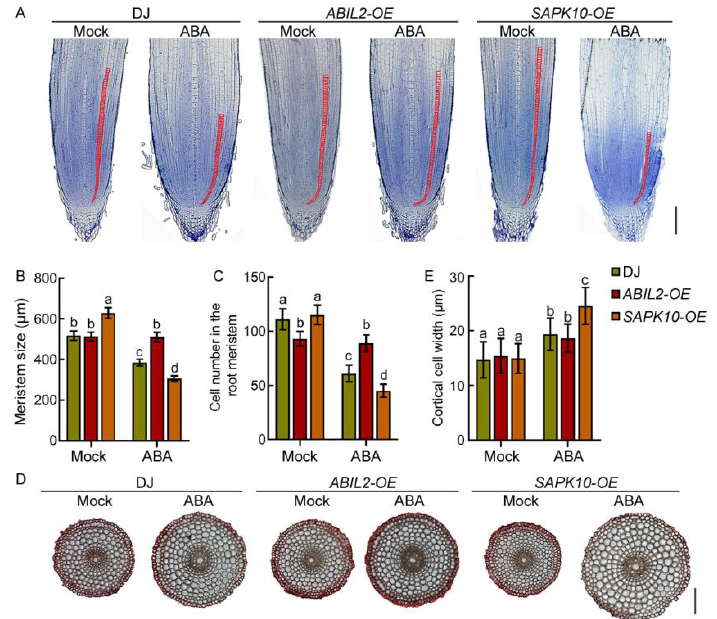
Figure 6. The regulation of ABA in cell proliferation and expansion in the root meristem depends on ABA signaling. ( A , D ) Longitudinal sections and cross-sections of primary root tips (lower) of 4-day-old Dongjing (DJ), ABIL2-OE , and SAPK10-OE seedlings with or without ABA treatment. Red lines delimit the meristem size ( A ). Bar = 100 µ m. ( B , C , E ) Length of root meristematic zone ( B ), cortical cell number in the root meristem zone ( C ), and diameter of cortical cells ( E ) of the corresponding seedlings indicated in ( A , D ). Data are means ± SD ( n ≥ 10 independent seedlings). Different letters indicate significant differences ( p < 0.05, one-way ANOVA with Tukey’s